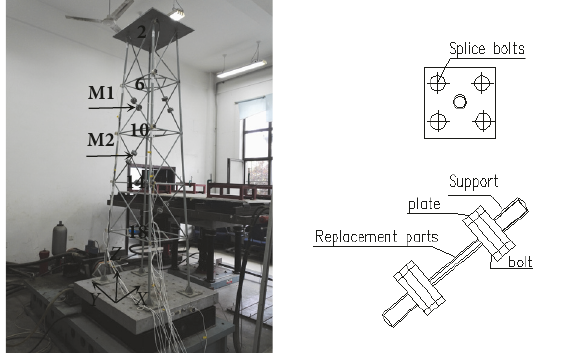
Figure 4: The offshore platform shaking table model